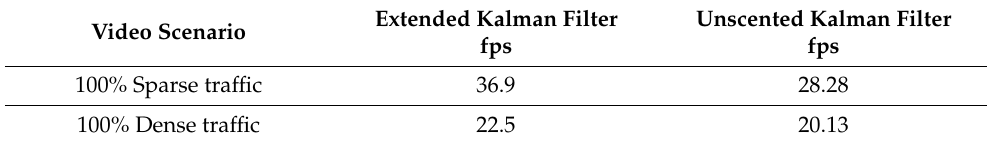
Table 2. Speed of different fusion architecture with fixed